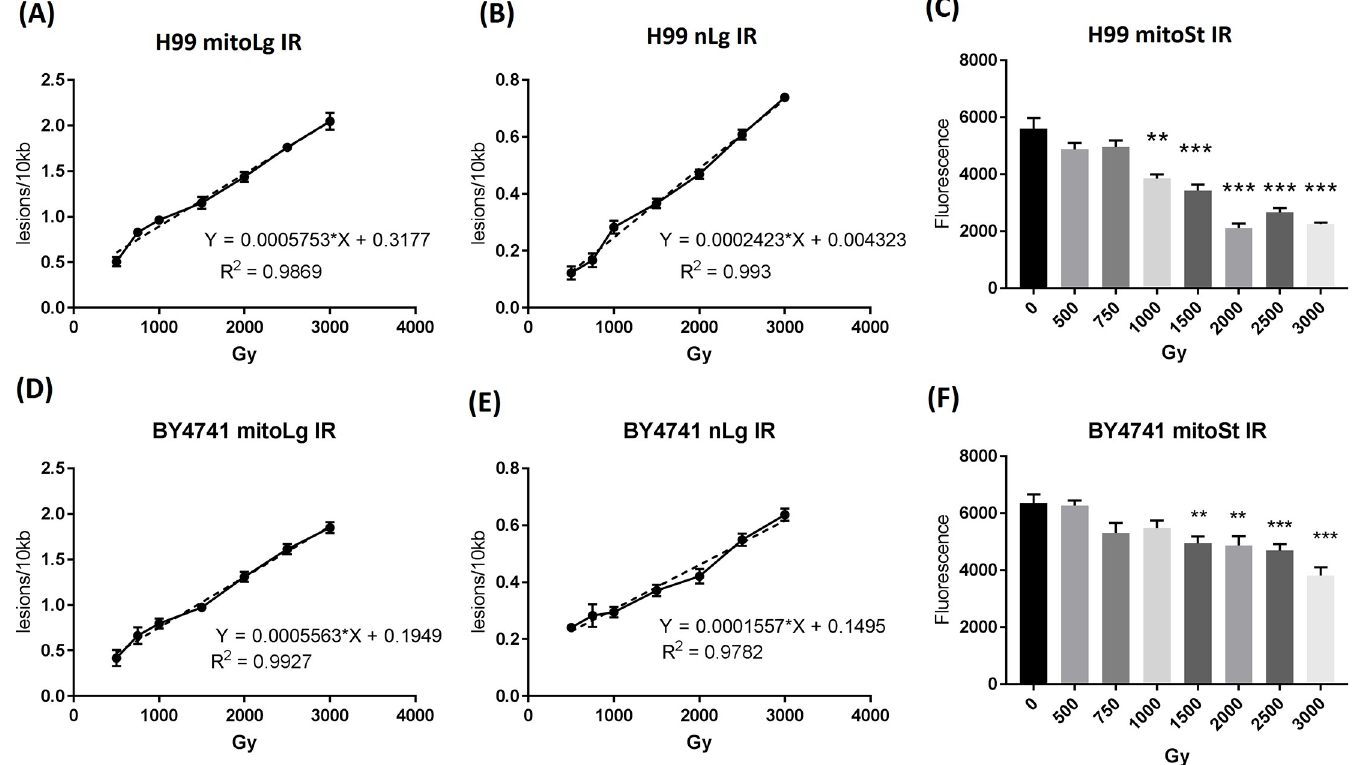
Fig 3. Quantitative detection of DNA damage in C . neoformans H99 and S . cerevisiae BY4741 exposed to ionizing radiation using the long mitochondrial DNA and nuclear DNA fragments. H99 and BY4741 cells were exposed to ionizing radiation from doses of 500 Gy to 3000 Gy. Irradiated cells were immediately frozen at -80 ˚ C and DNA extraction was performed as described in the Material and Methods. PCR products were quantified using the PicoGreen assay. DNA lesions were calculated according to the formula (lesions/amplified fragment = -ln (A D /A C )). The solid lines are lines connecting each data point. The dotted lines are the linear regression lines. (A and D) long mitochondrial DNA fragment lesions, (B and E) long nuclear DNA fragment lesions, (C and F) short mitochondrial DNA fragment PCR yield. Results were from three independent experiments with triplicate samples in each experiment (3 samples/point/experiment x 3). Mean ± S.E.M. �� , p < 0.01; ��� , p <